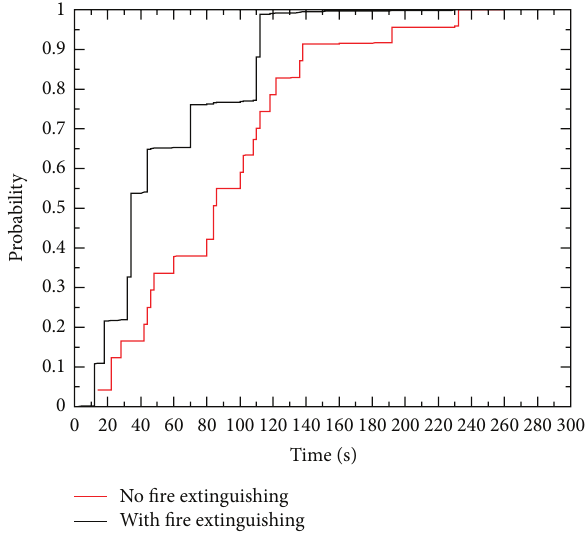
Figure 5: Distribution of the time period with the temperature inside the cable jacket exceeding 160 ∘ C.